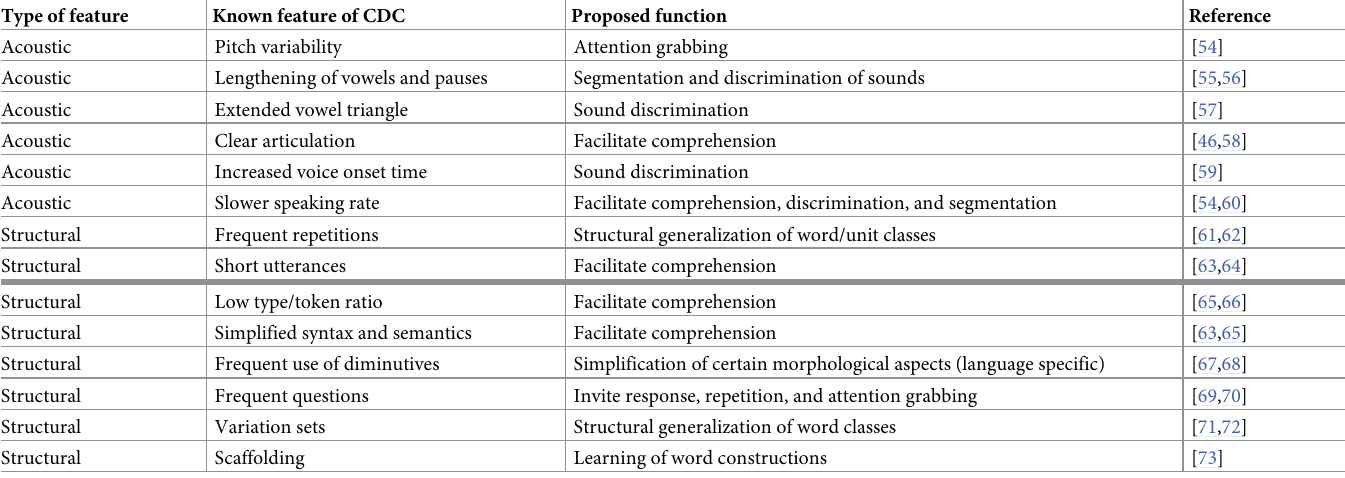
Table 1. Known features of